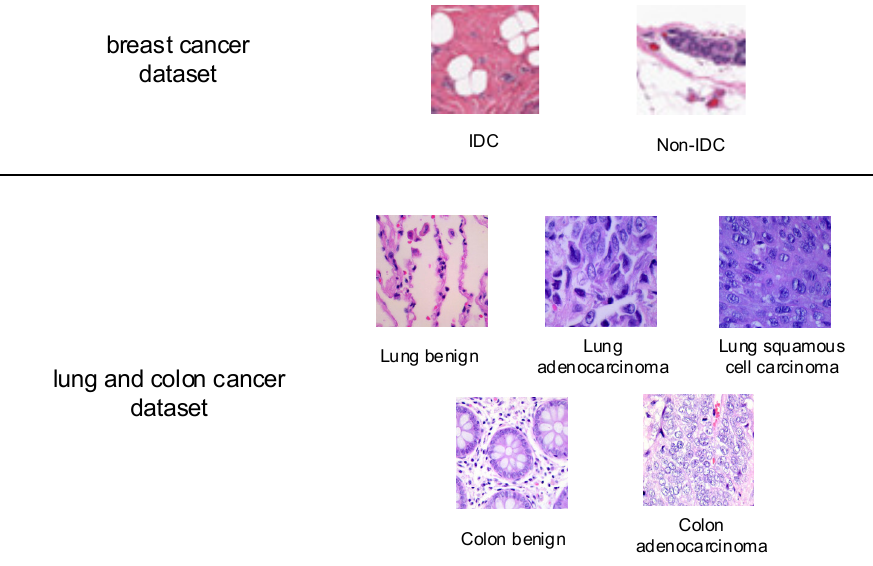
Figure 3. Sample images from breast cancer dataset, and lung and colon cancer dataset.